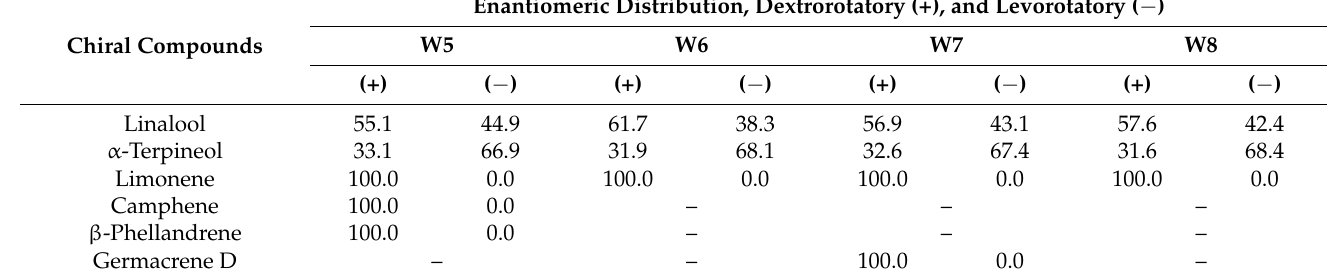
Table 10. Enantiomeric distributions of chiral terpenoids present in wintergreen essential oil based on different distillation conditions; “–” indicates not detected; “+” indicates dextrorotatory. Enantiomeric Distribution, Dextrorotatory (+), and Levorotatory ( − )